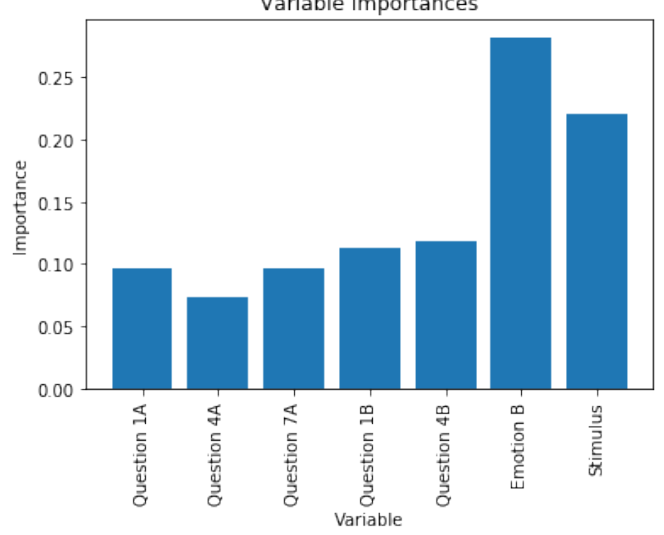
Figure 1. Importance of Model Variables.